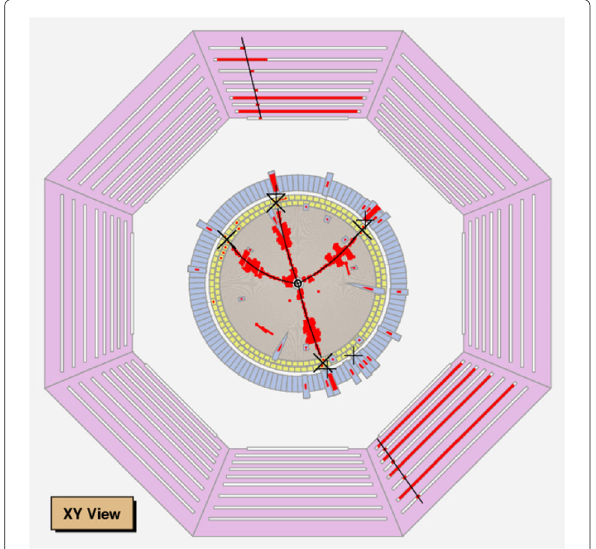
Fig. 4 The event shape of Y ( 4260 ) → π + π − J /ψ with J /ψ → μ + μ − events inside the BESIII